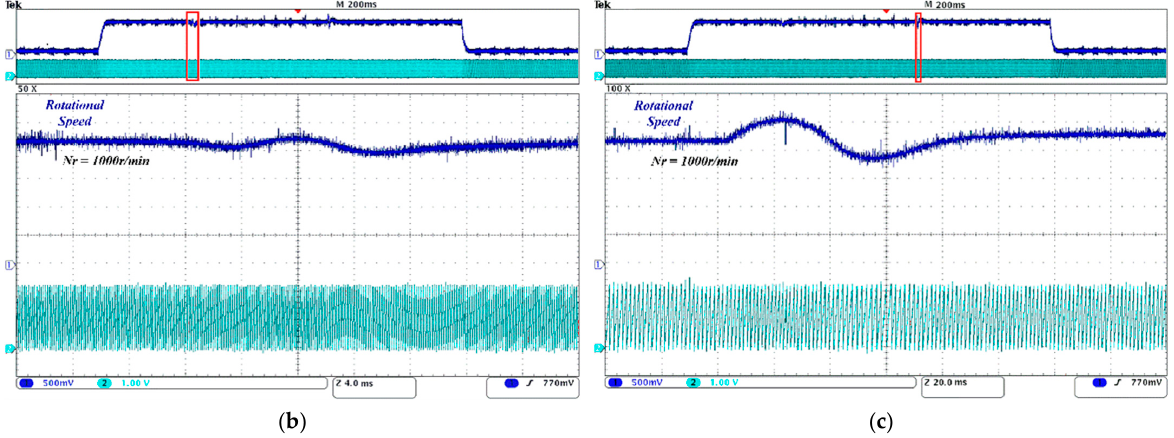
Figure 8. PMSM rotor position angle and speed waveforms. ( a ) Full working condition response waveform, ( b ) Speed response during loading, ( c ) Speed response at reduced load.